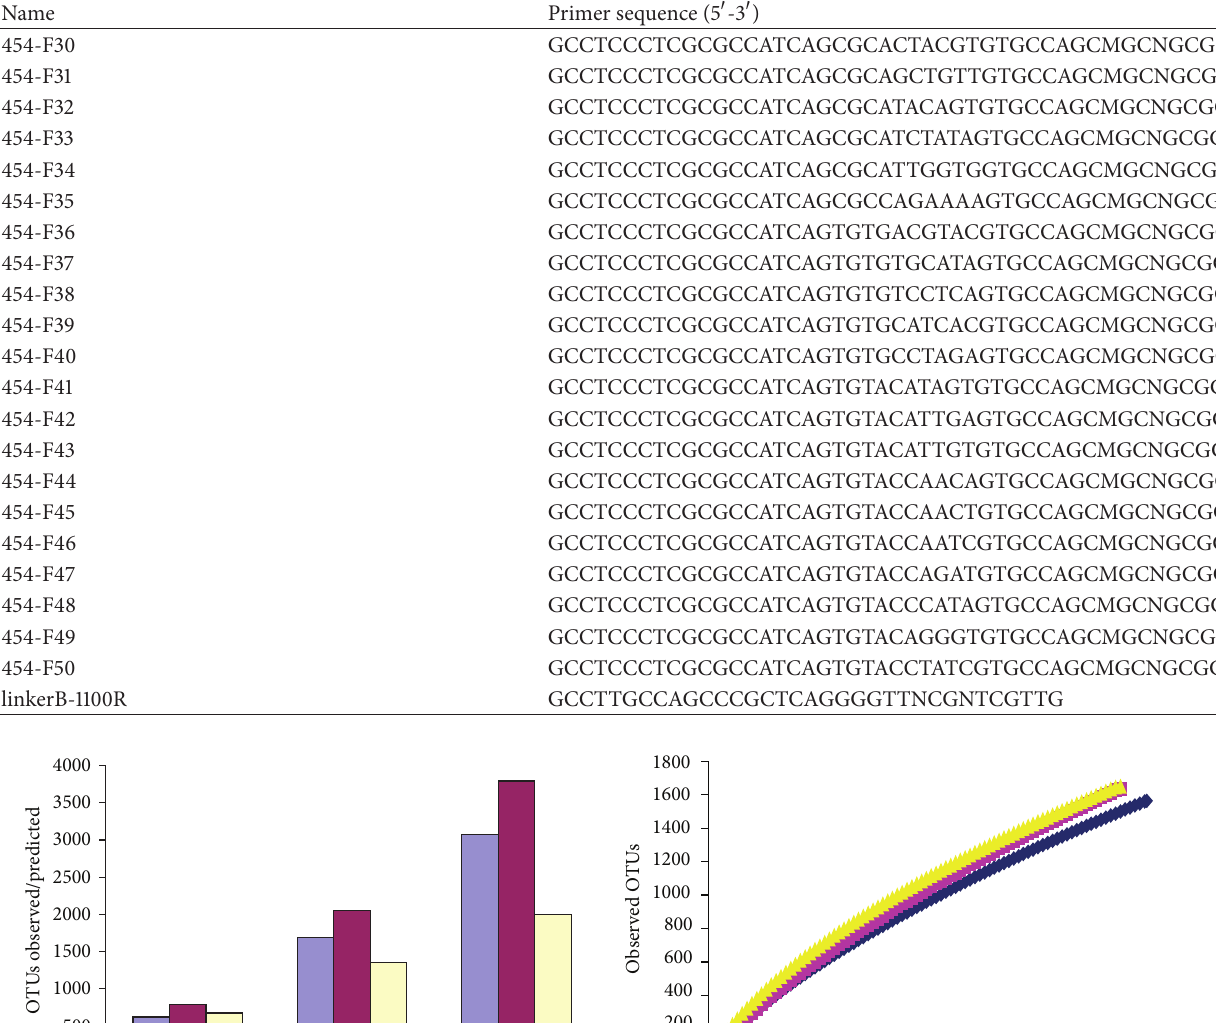
Table 2: Primer sequences utilized for goats samples during bTEFAP.